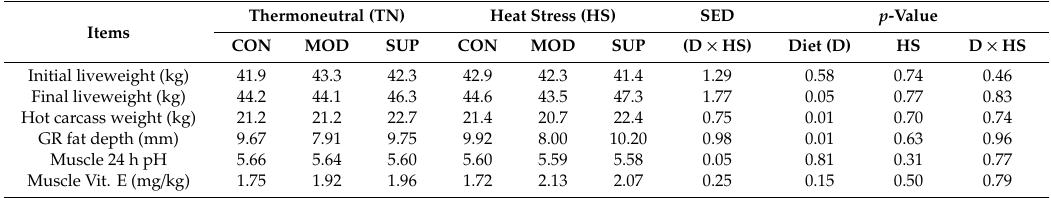
Table 1. E ff ect of 4 weeks of dietary antioxidant (vitamin E and selenium) supplementation on carcass characteristics and muscle vitamin E concentration in finisher lambs exposed to one week of heat stress.